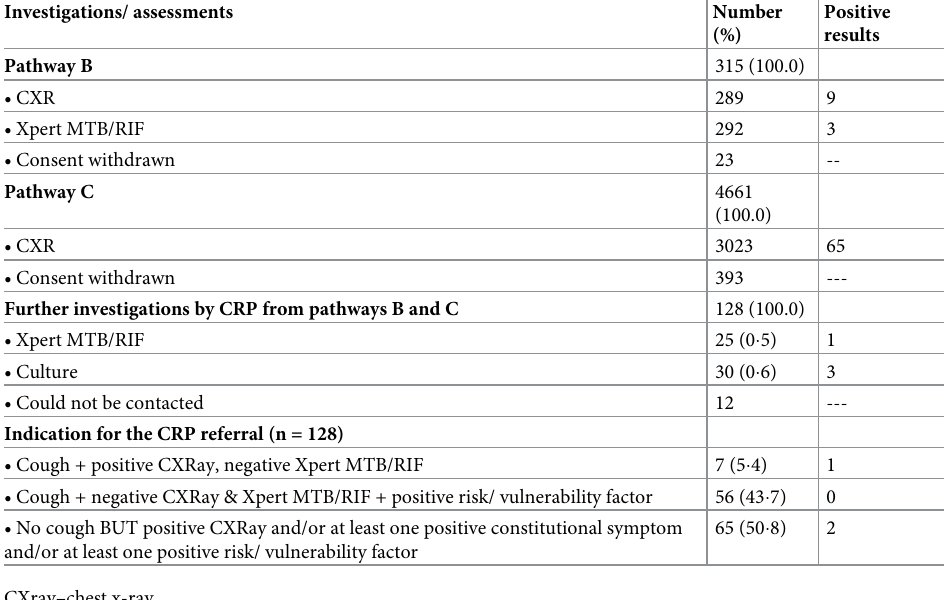
Table 2. Distribution of the study units who completed the study by investigations and assessments conducted (n = 4548). Investigations/